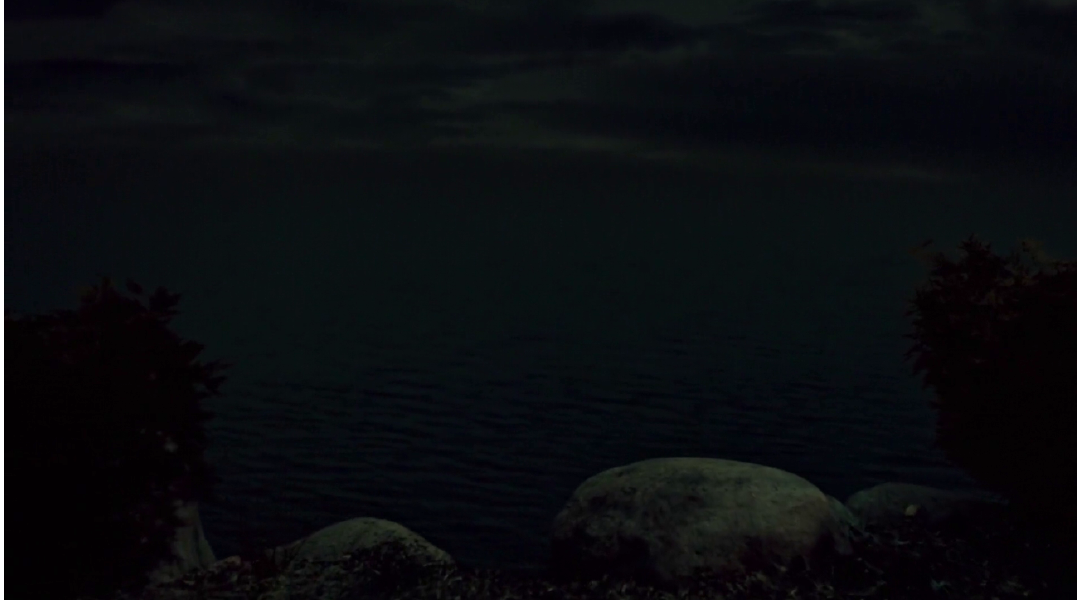
Figure 12. Return to nigredo? The tracking shot moves from over the cliff towards the murky waters below. Darkness prevails. We are back to square one (and to Will’s natural element); the descent to hell is happening again. Screencap from the thir- teenth (and final) episode of season 3, “The Wrath of the